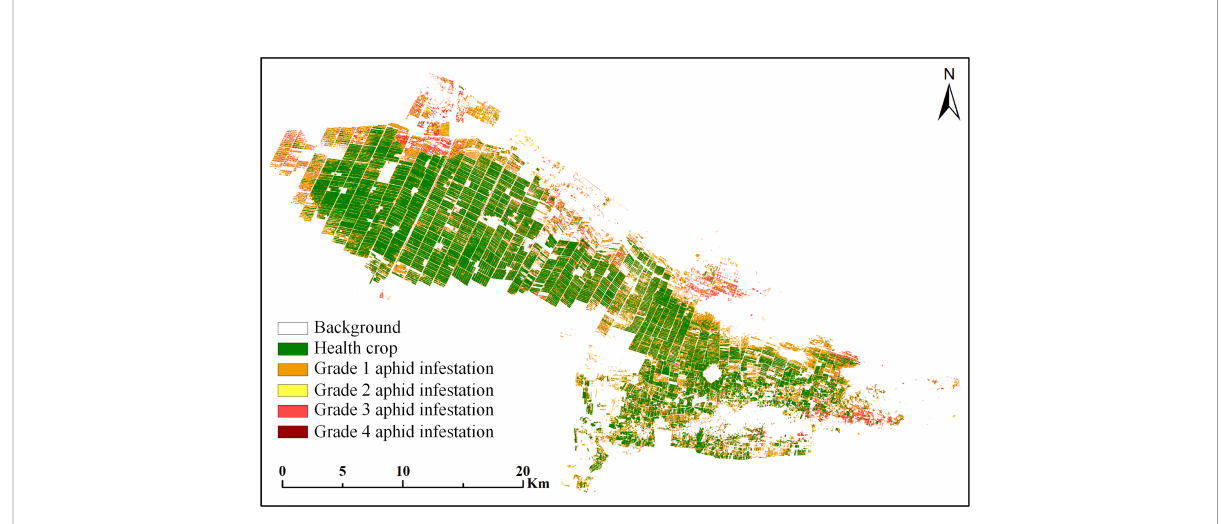
FIGURE 10 RF classi fi cation results of cotton aphid infestation at different grades.